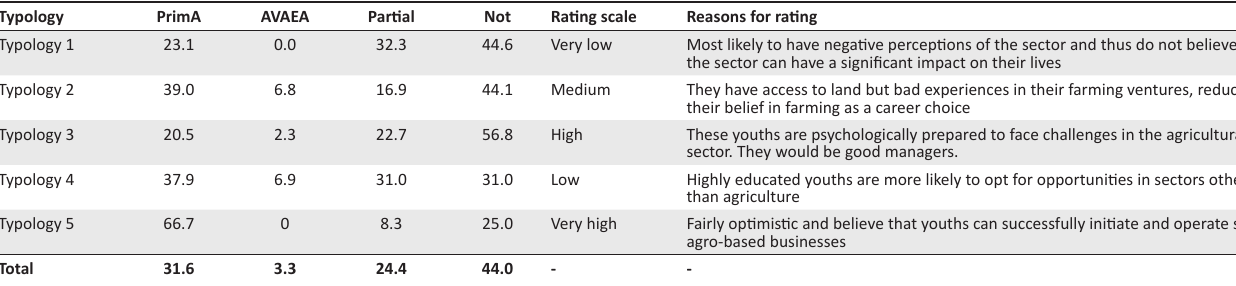
Note: Rating scale, rates the potential to successfully participate in farming; PrimA, Actively engaged in primary agriculture; AVAEA, Actively involved in AVAEAs; Partial – Partially involved in agriculture; Not, Not engaged in farming. AVAEA, Agricultural value-added economic